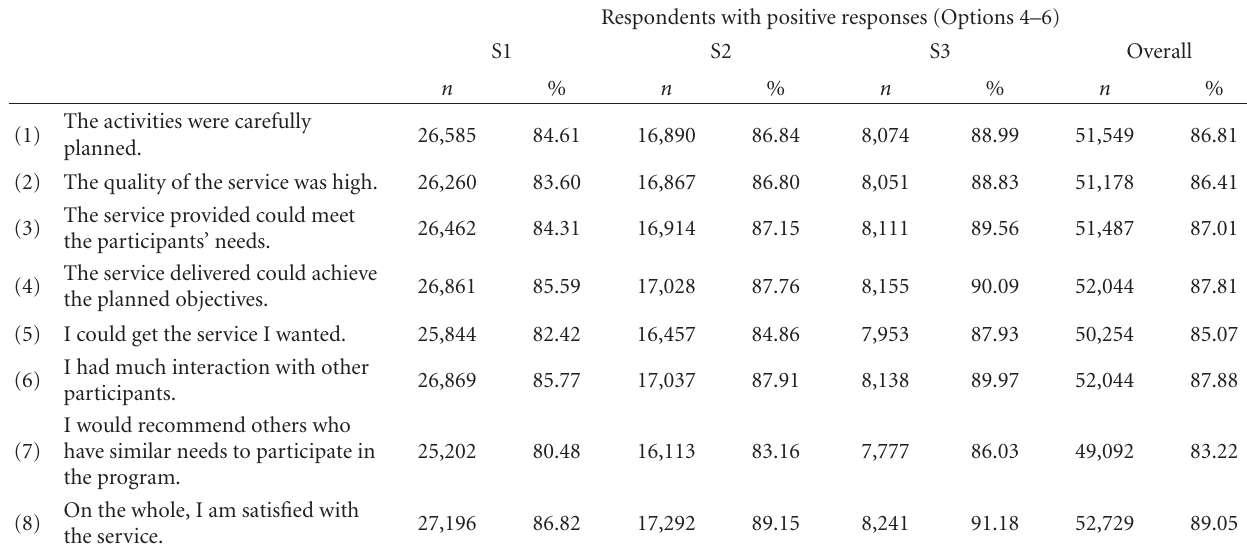
Table 3: Summary of the students’ perception towards the